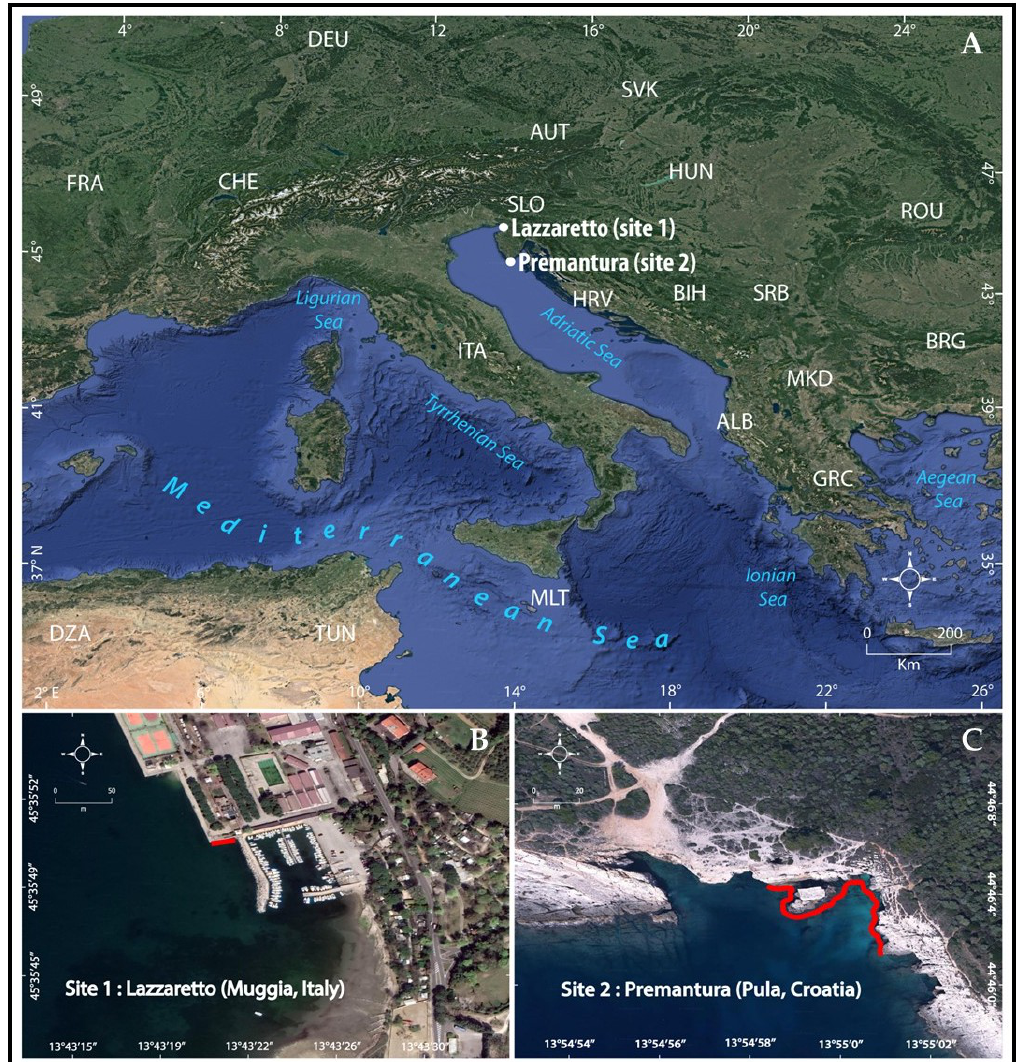
Figure 1. ( A ) The studied sites are highlighted with white circles; ( B ) site 1, Lazzaretto harbor (Trieste, Italy); ( C ) site 2, Premantura (Pula,